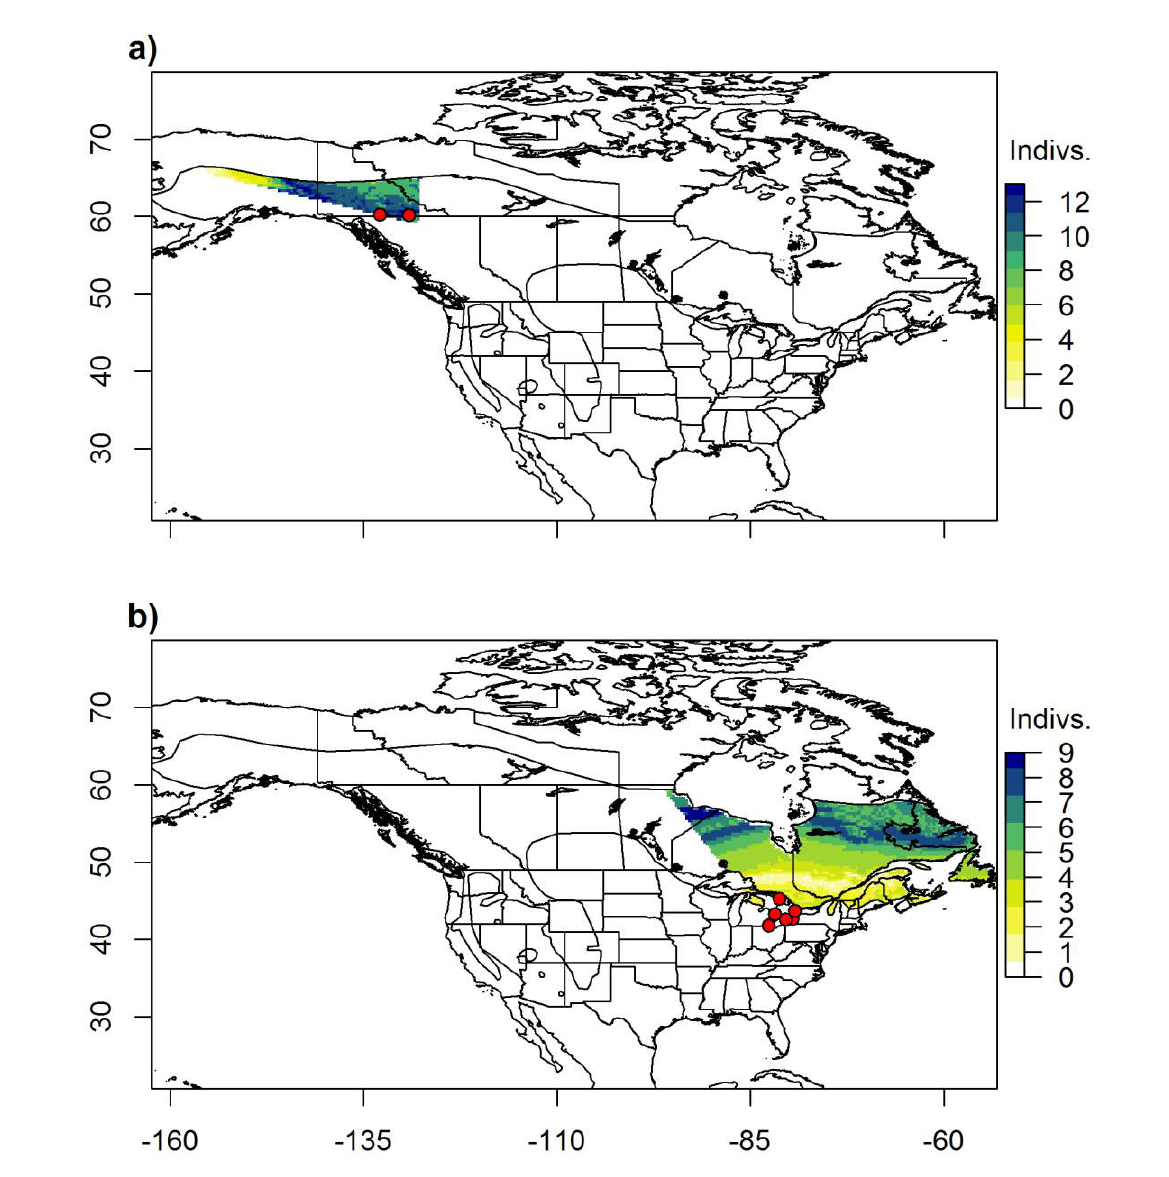
Figure A2.22: Probable origins of Lincoln’s Sparrows ( Melospiza lincolnii ) captured during spring migration at CMMN stations in a) Yukon (ACBO (n=12), TLBBS (n=8)); b) Southwest Ontario (AuBO (n=2), BPBO (n=1), HBO (n=3), LPBO (n=5), PIBO (n=1), TTPBRS